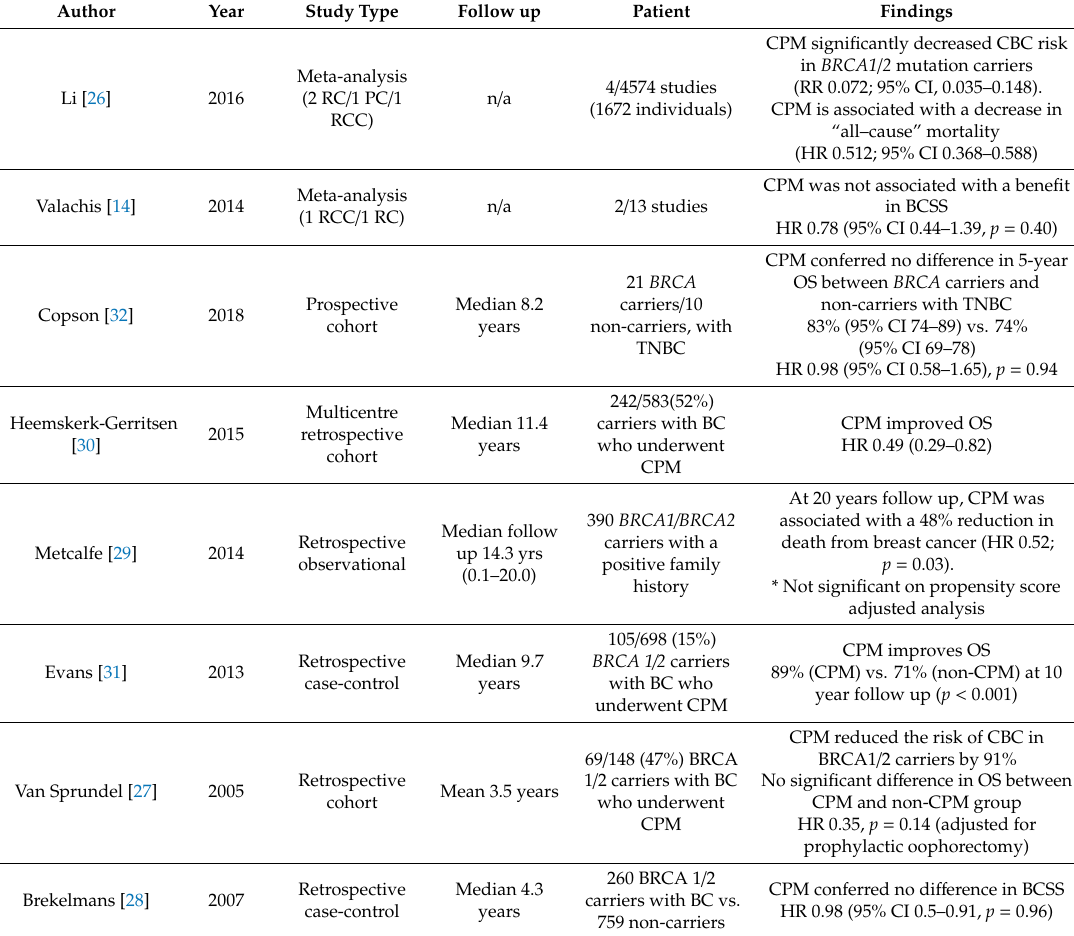
Table 1. Studies looking at the impact of CPM on CBC risk and survival in BRCA1 / 2 mutation